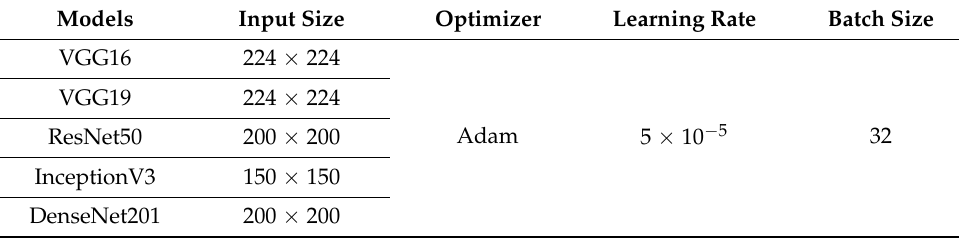
Table 3. Parameters and values of the five pre-trained CNNs used in this